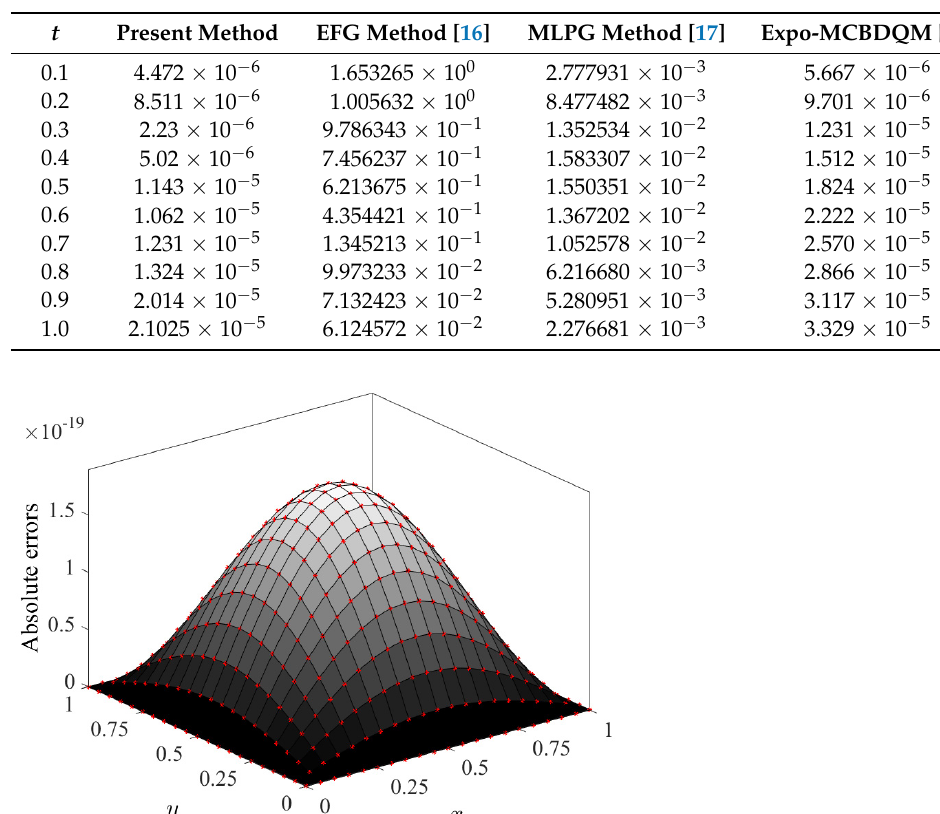
Table 3. Comparison between the present method and existing methods with h = 0.1 and ∆ t = 0.01 at different values of t for Example 2.